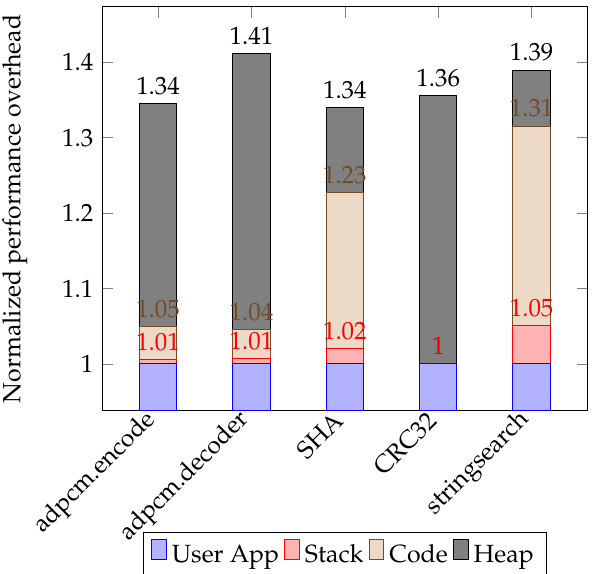
Figure 15. The normalized performance of SPM